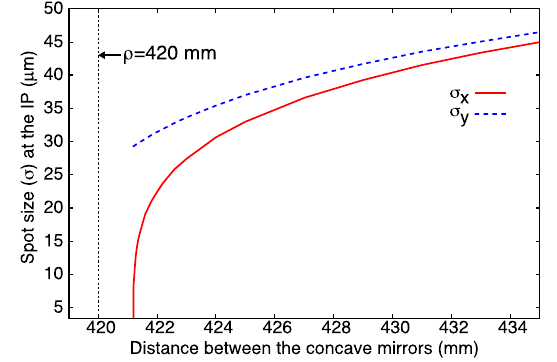
beam.FIG. 9. Dependence of the spot size at the IP on distance between the concave mirrors.